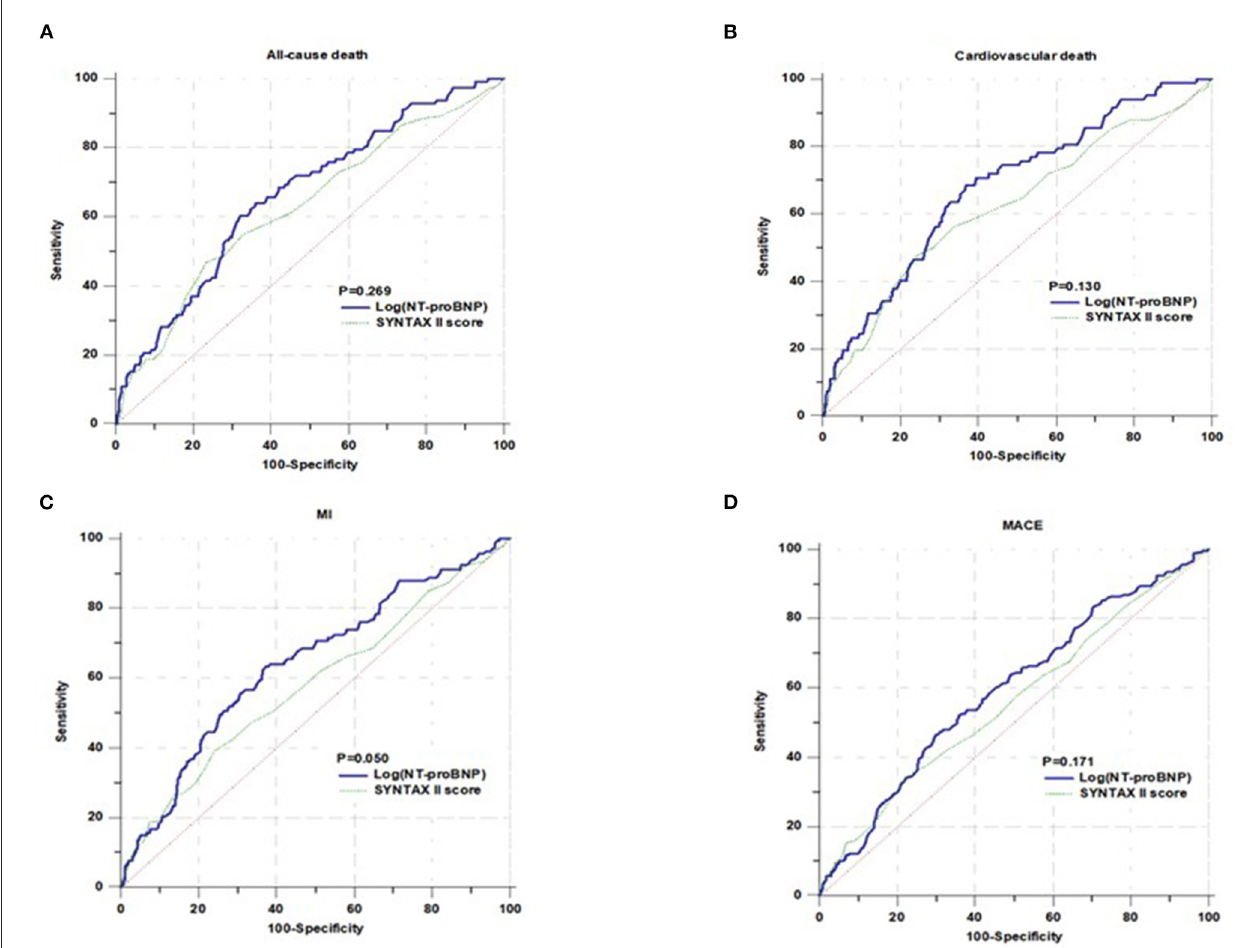
FIGURE 2 | Comparison of area under the receiver operating characteristic cures for predicting all-cause death (A) , cardiovascular death (B) , MI (C) , and MACE (D) .